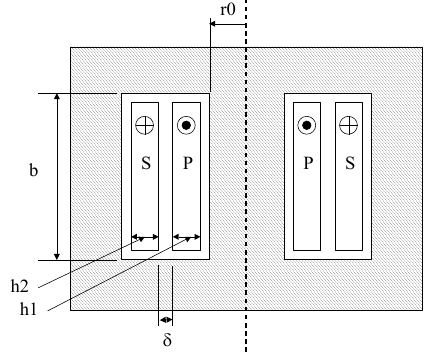
Figure 1: Basic Transformer Winding